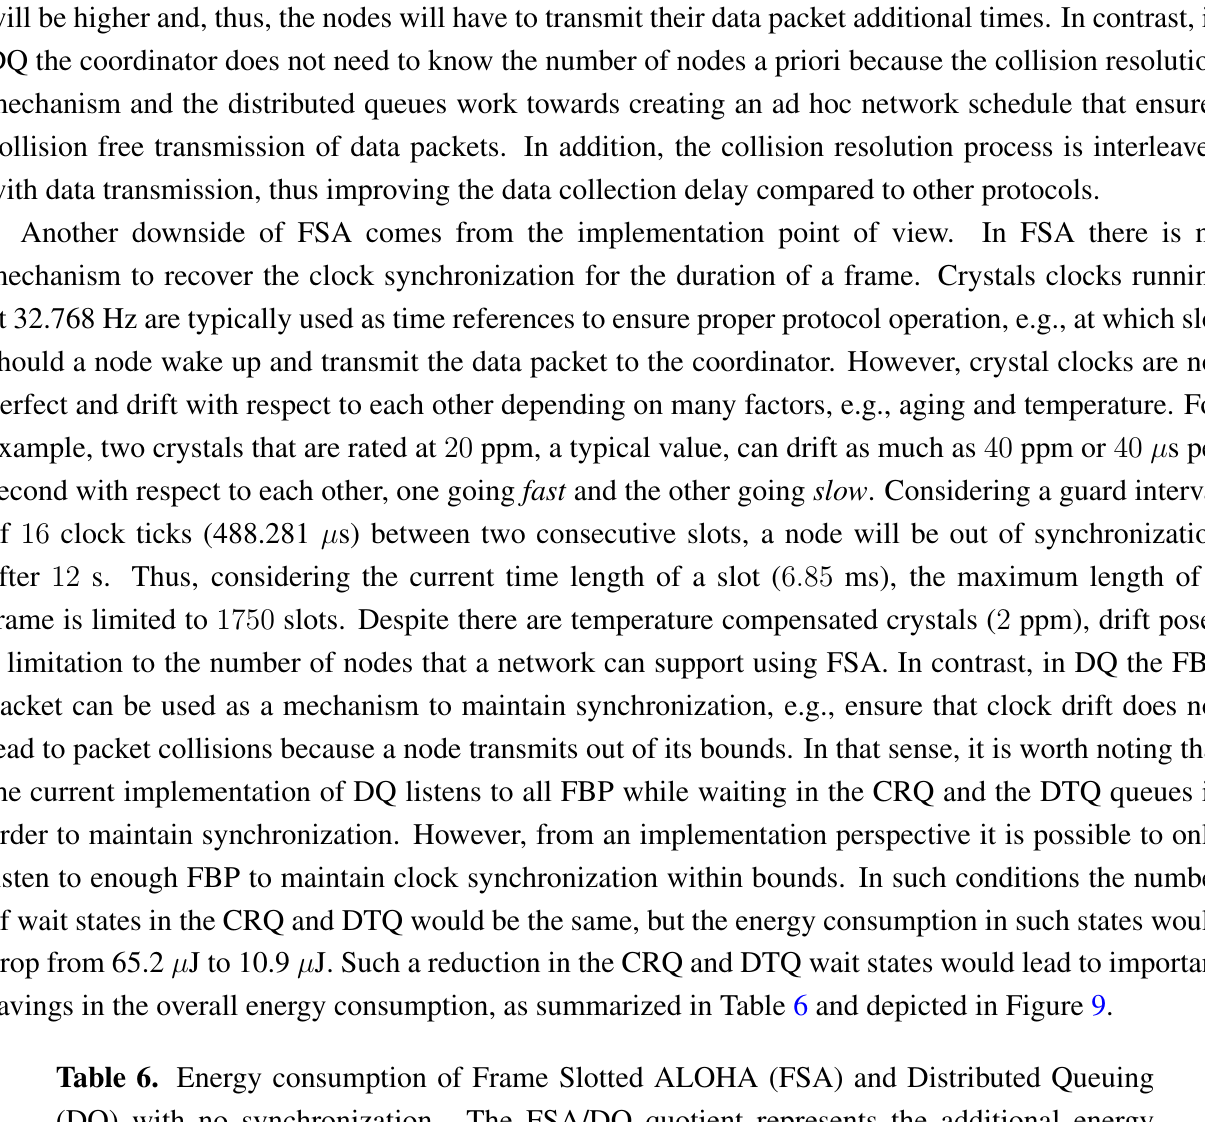
Table 6. Energy consumption of Frame Slotted ALOHA (FSA) and Distributed Queuing (DQ) with no synchronization. The FSA/DQ quotient represents the additional energy expenditure of using FSA with respect to DQ. Assuming perfect synchronization, the